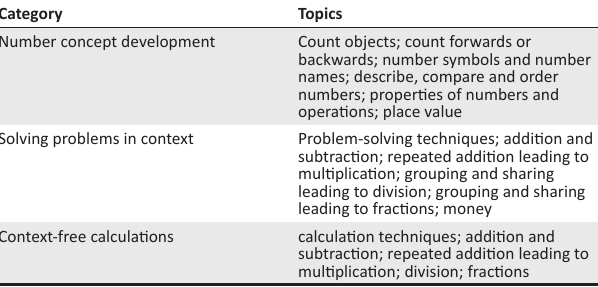
TABLE 5: Topics for Numbers, Operations and Relationships in CAPS. Category